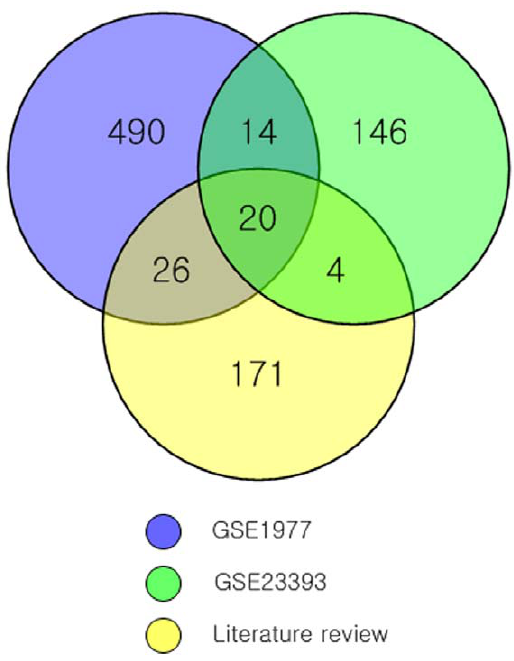
Figure 4. Comparison of significant genes among three sources. A Venn diagram depicting the number of shared and unique genes among a set of genes identified by literature review and two sets of genes identified in the analysis of two gene microarray datasets.